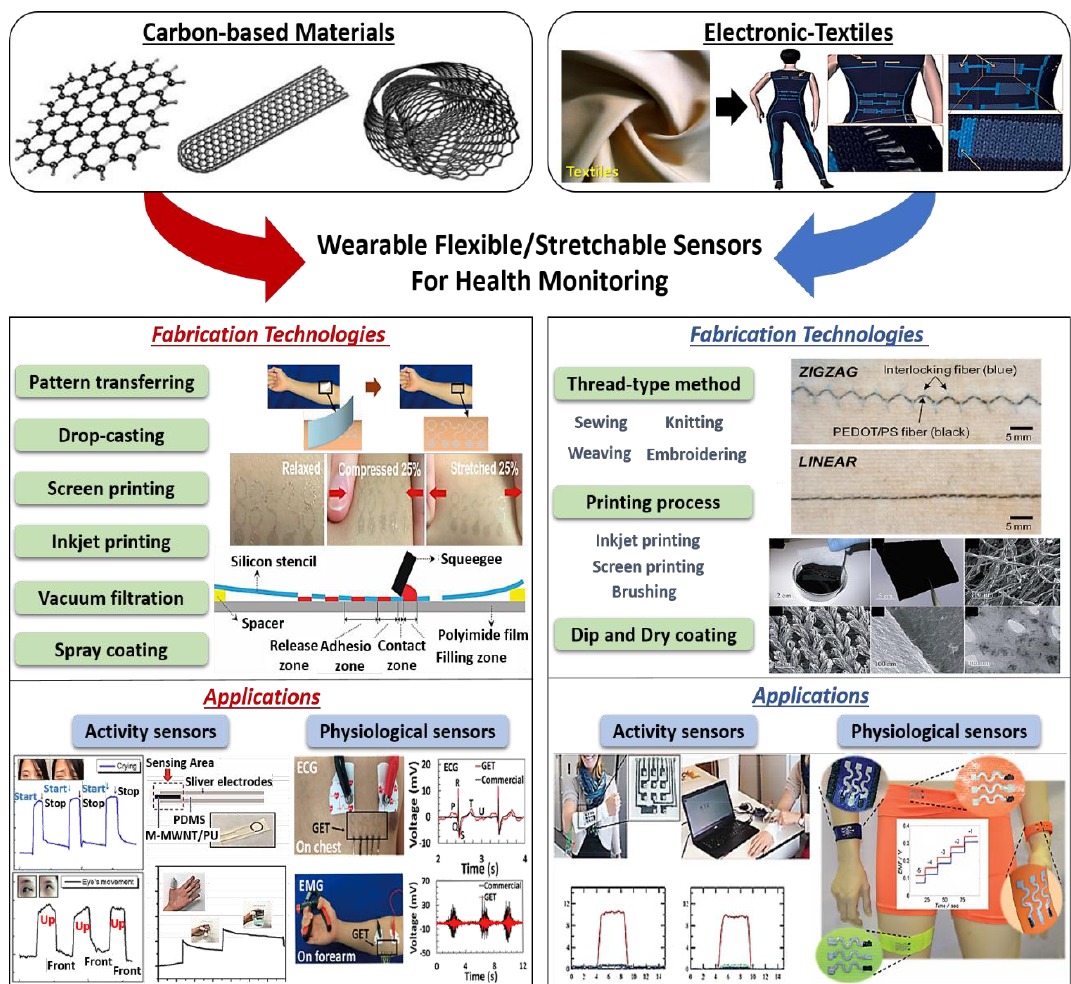
ff ective approaches for wearable flexible / stretchable sensor applications Figure 1. Schematic of effective approaches for wearable flexible/stretchable sensor applications in Figure 1. Schematic of e